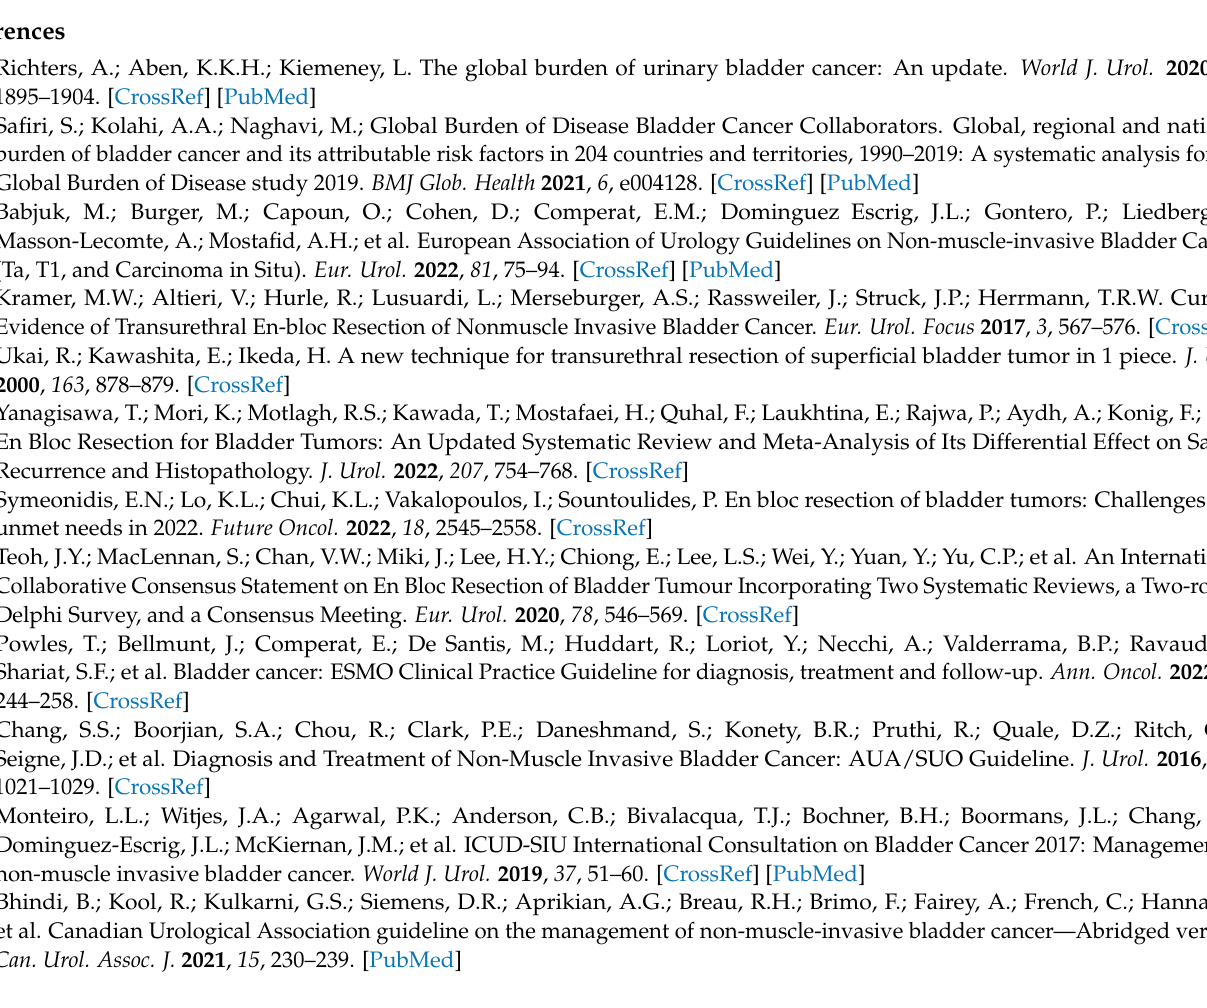
Table S2. Risk of bias assessment of included studies. Table S3. Egger test and Begg’s test for pooled comparisons and sensitivity analysis by trim and fill method. Figure S1. Funnel plots of sensitivity